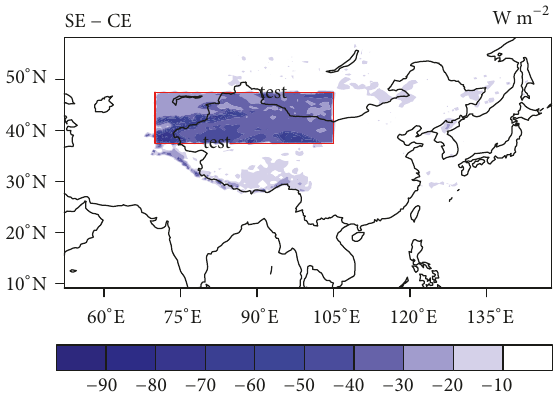
Figure 4: Difference of surface net downward shortwave radiation flux (Wm −2 ) between sensitivity experiment (SE) and control experiment (CE) in April averaged from 2001 to